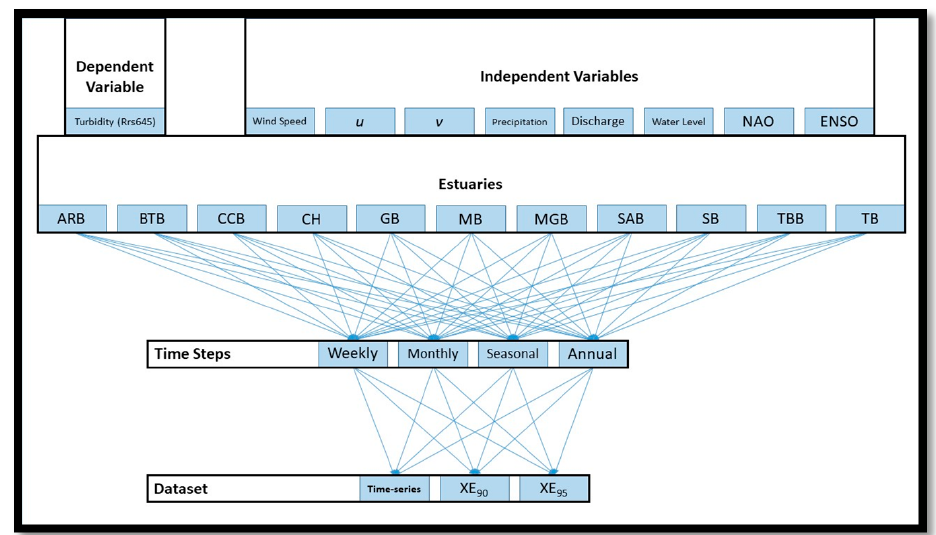
Figure 2. Summary of the variables, estuaries, time steps and datasets used for statistical analyses.